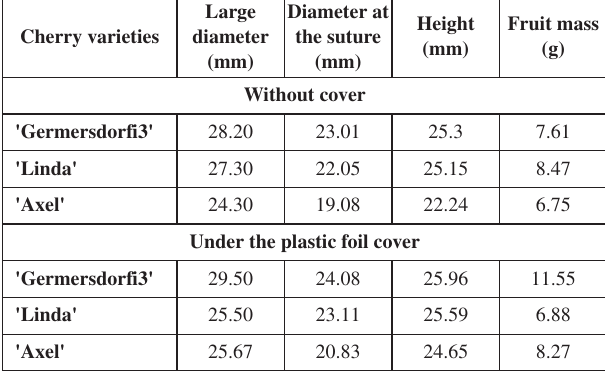
Table 1. Size measures and mass of cherry fruits of three varieties grown without and under the plastic foil cover ( Debrecen–Pallag, 2010) Large Cherry varieties